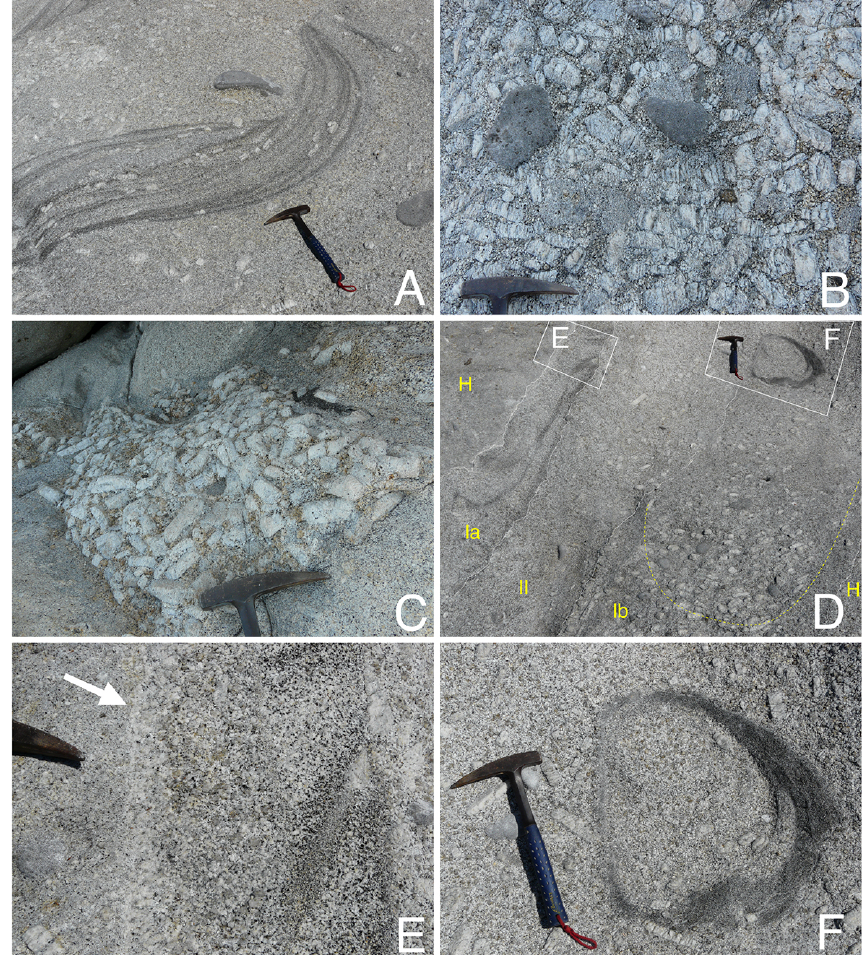
Figure 10. Photographs of the root zone of the Sant’Andrea facies in the melange zone in and around the Cotoncello dyke. (a) Schlieren with cross-bedding. (b) Mush zone with cluster of K-feldspar megacrysts and mafic enclaves. (c) Isolated blob of mush zone with large K-feldspar megacrysts. (d) Folded alternation of leucocratic and melanocratic layers with schlieren. (e) Detail of (d) schlieren. (f) Detail of (d) schlieren